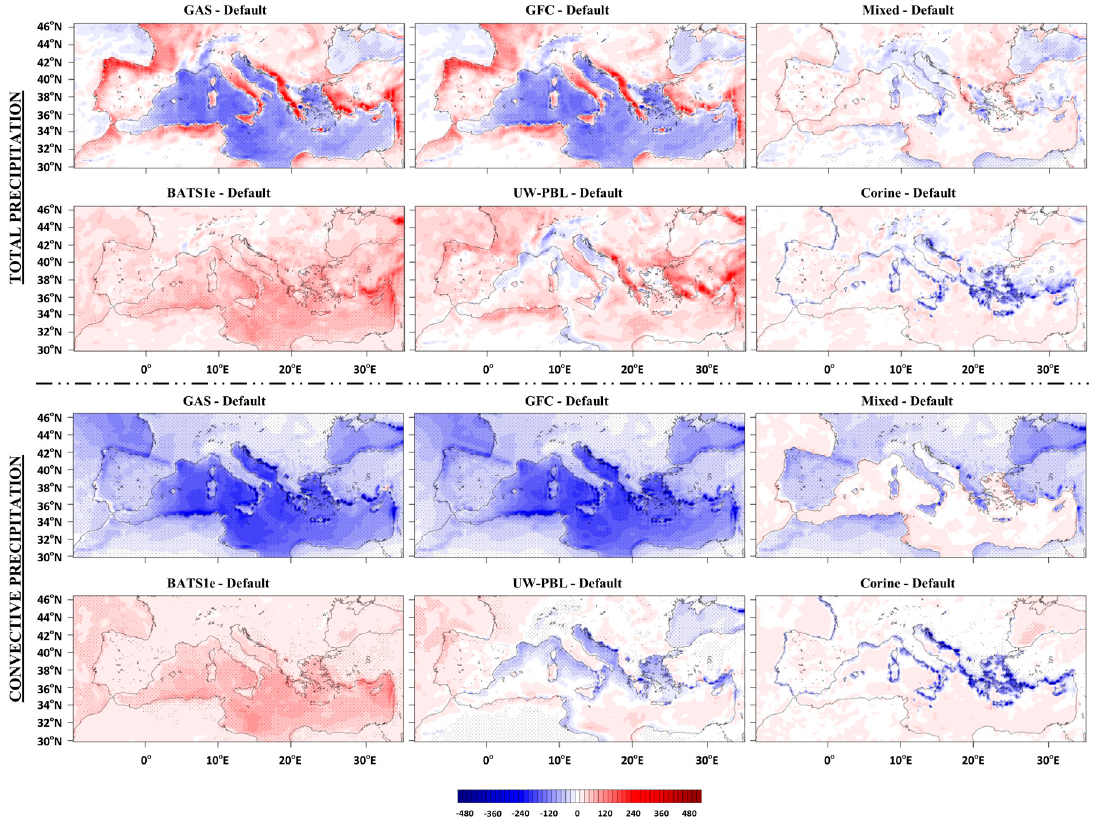
Figure 3. Differences in total and convective precipitation from the default simulation for the performed simulations during winter. The statistical significance of the differences in the maps is represented by the dotted